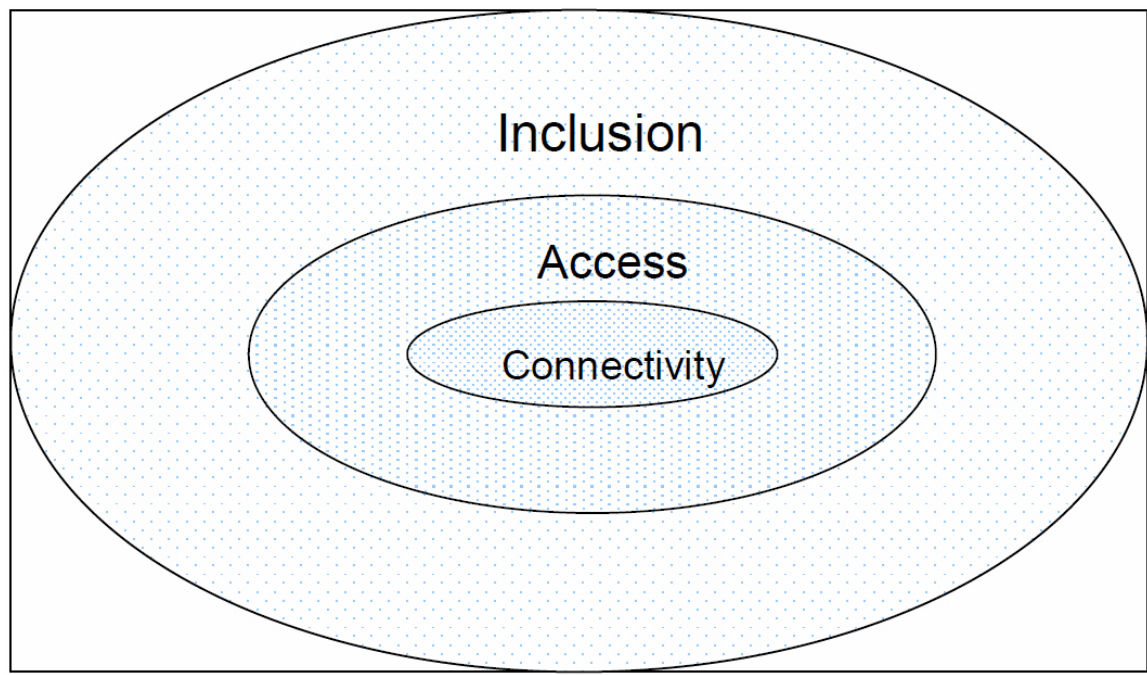
Figure 1: A Framework for Inclusion (Source: United Nations Global E-Government Readiness Report 2005 – From E-Government to E-Inclusion, UNPAN, 2005,